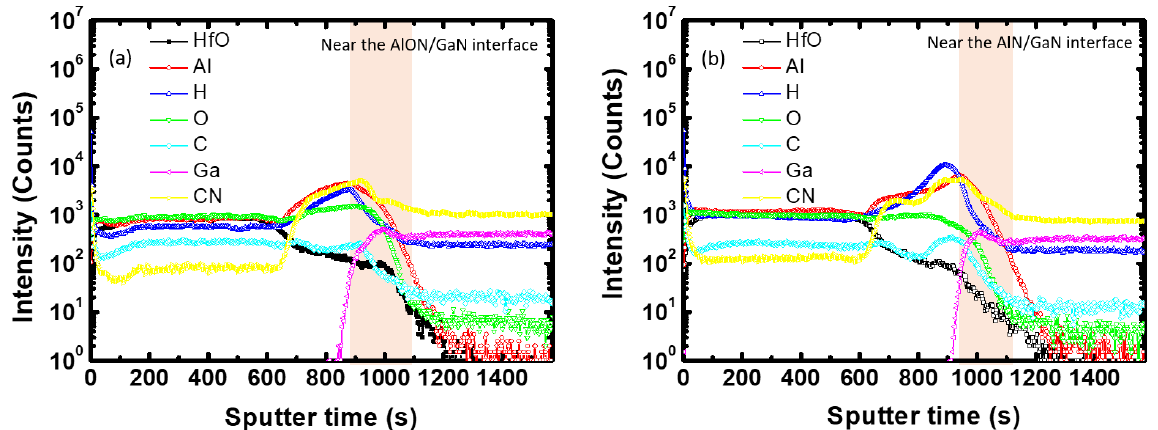
Figure 10. Time-of-flight (TOF)-secondary ion mass spectrometry (SIMS) results for ( a ) AlON/AlHfON (~5/~15 nm) and Figure 10 . Time-of-flight ( TOF ) - secondary ion mass spectrometry ( SIMS ) results for ( a ) AlON/AlHfON (~5/~15 nm) and ( b ) AlN/AlON/AlHfON (~2/~3/~15 nm) on n-GaN (NH 3 plasma power: 30 ( b ) AlN/AlON/AlHfON (~2/~3/~15 nm) on n-GaN (NH 3 plasma power: 30 W).